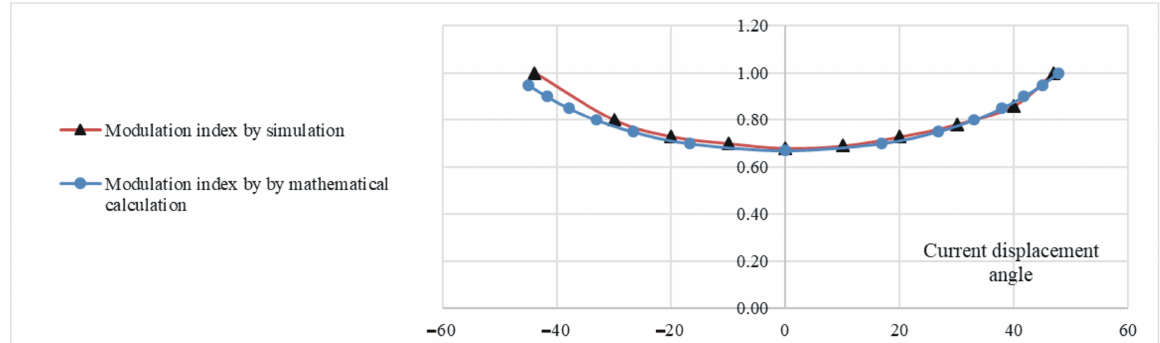
Figure 14. ISVM modulation index for voltage drop recovery.